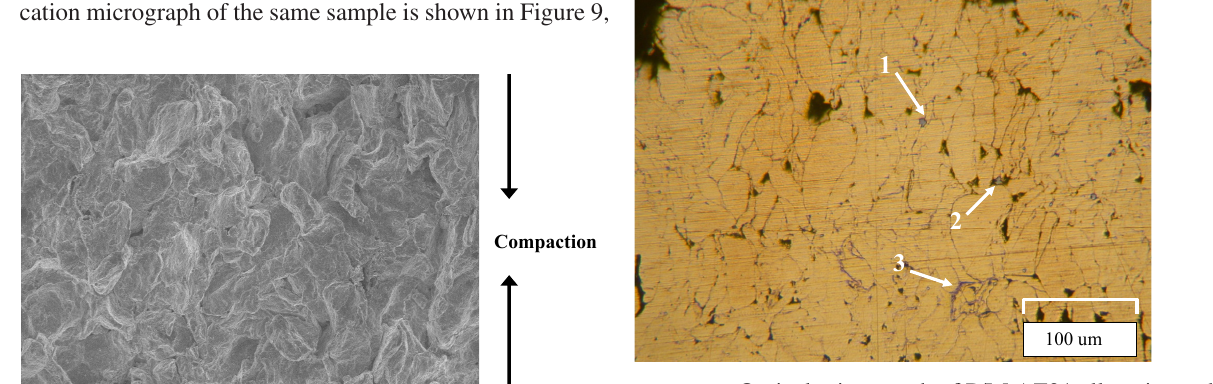
Figure 10. Optical micrograph of P/M AZ31 alloy sintered at 500˚C (500 MPa, 20 min, 450 °C). Arrows indicate light grey areas of frozen liquid phase inside porosity (1, 2), and along grain boundaries (3).